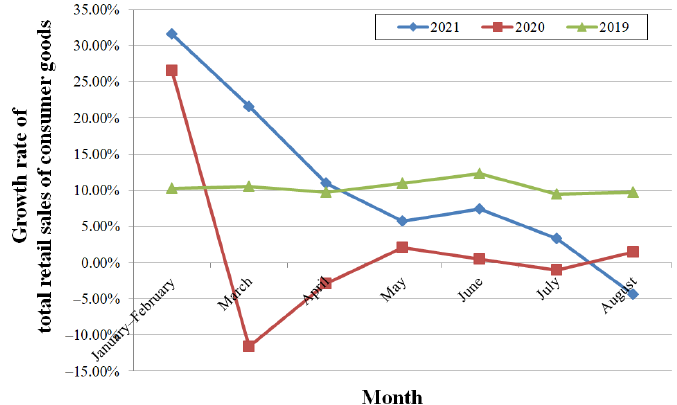
Figure 11. The YoY growth rate of total retail sales of consumer goods.